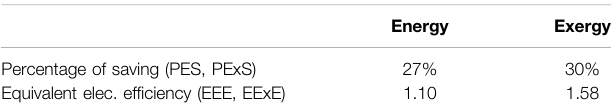
TABLE 3 | Cogeneration indices in energy and exergy